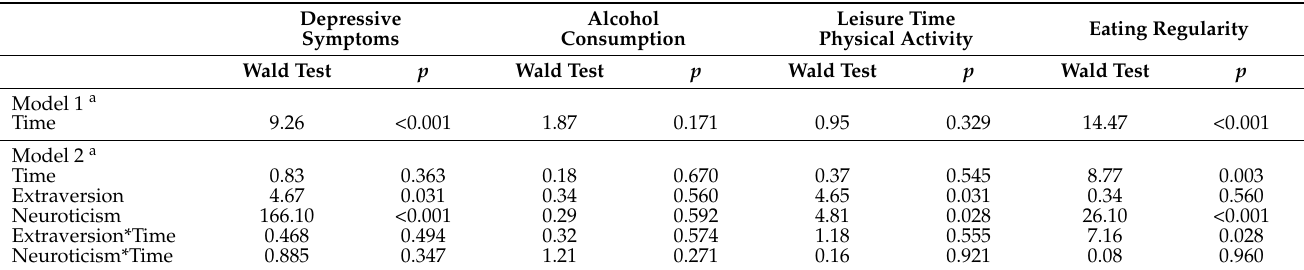
Table 3. Changes in depressive symptoms and health behaviors analyzed by general equation estimation ( n =